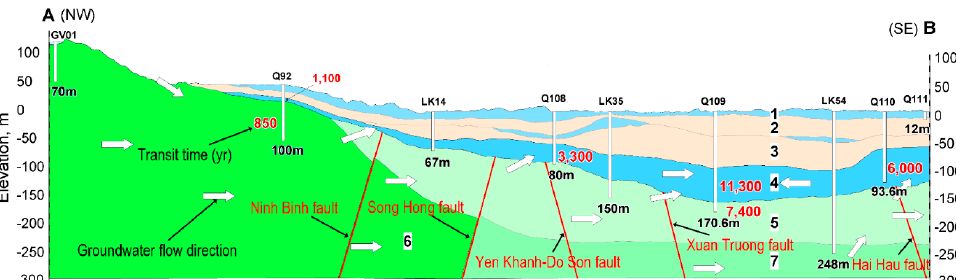
Figure 5. 14 C-ages and conceptual model indicating flow directions of groundwater in Pleistocene, Neogene and Triassic aquifers in the study region.